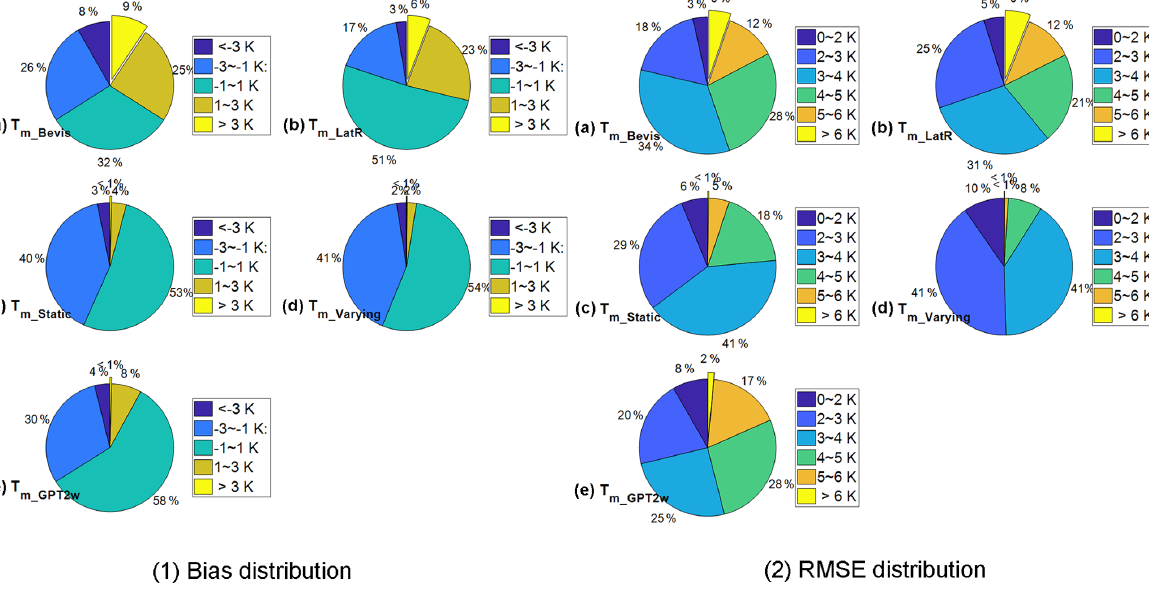
Figure 7. The distributions of (1) the biases and (2) the RMSEs of T m_Bevis , T m_LatR , T m_static , T m_varying and T m_GPT2w compared with the radiosonde data at 723 stations in the year 2016. Temperature unit is